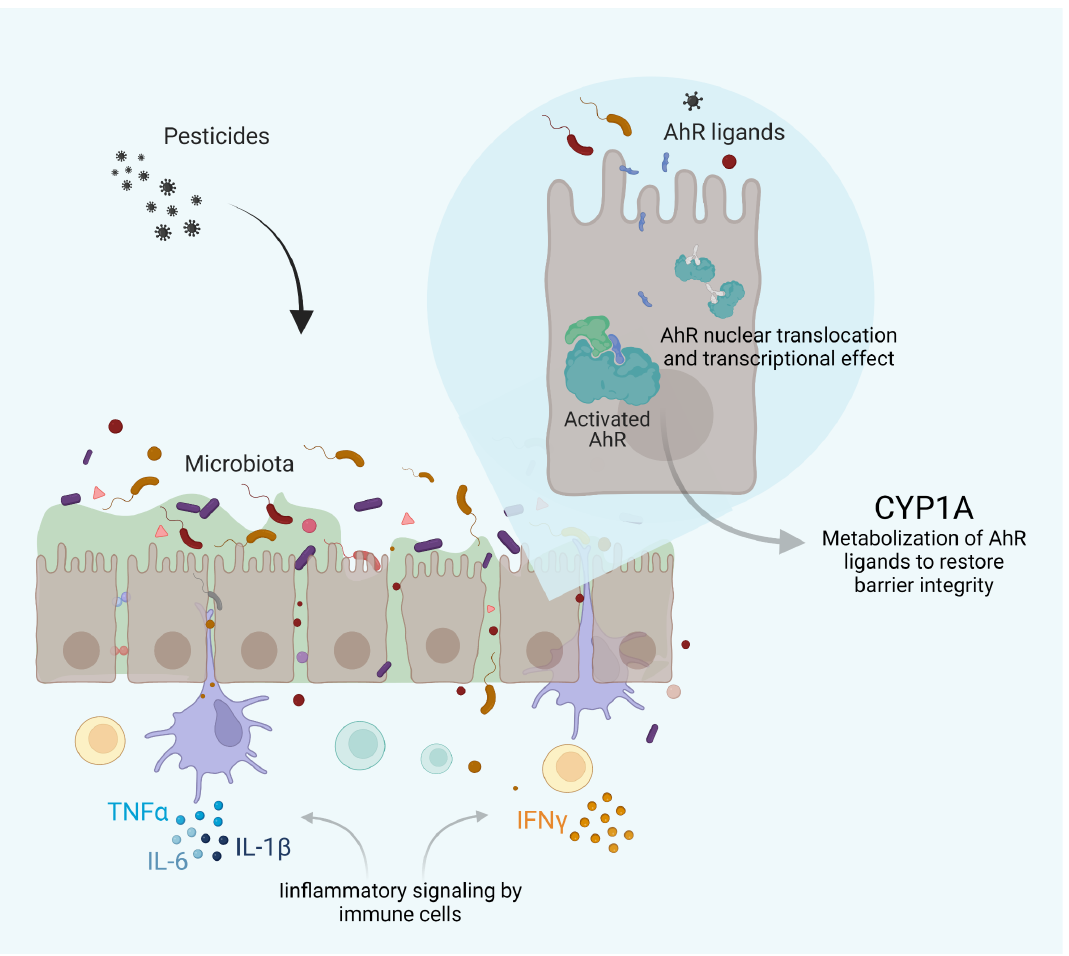
Figure 2. AhR signaling in pesticide-induced dysbiosis, and inflammation. AhR acts as a ligand- activated sensor of endogenous and exogenous factors. After dimerization with AhR nuclear trans- locator (ARNT), it binds to response elements in the DNA and promotes the transcription of genes involved in physiological pathways, notably CYP1A expression, contributing to maintain the epi- thelial barrier integrity. However, in dysbiosis, deregulated production of microbiome metabolites is responsible for altered stimulation of the AhR pathway, promoting inflammation. Created with BioRender.com.